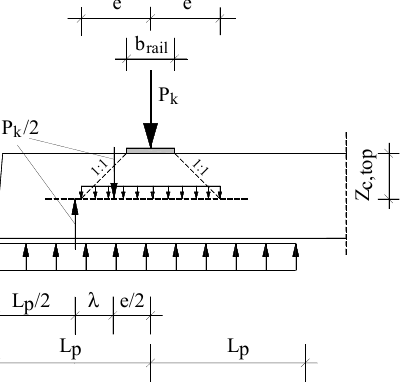
Figure 7. Model of the load distribution in the bearer at the rail seat.